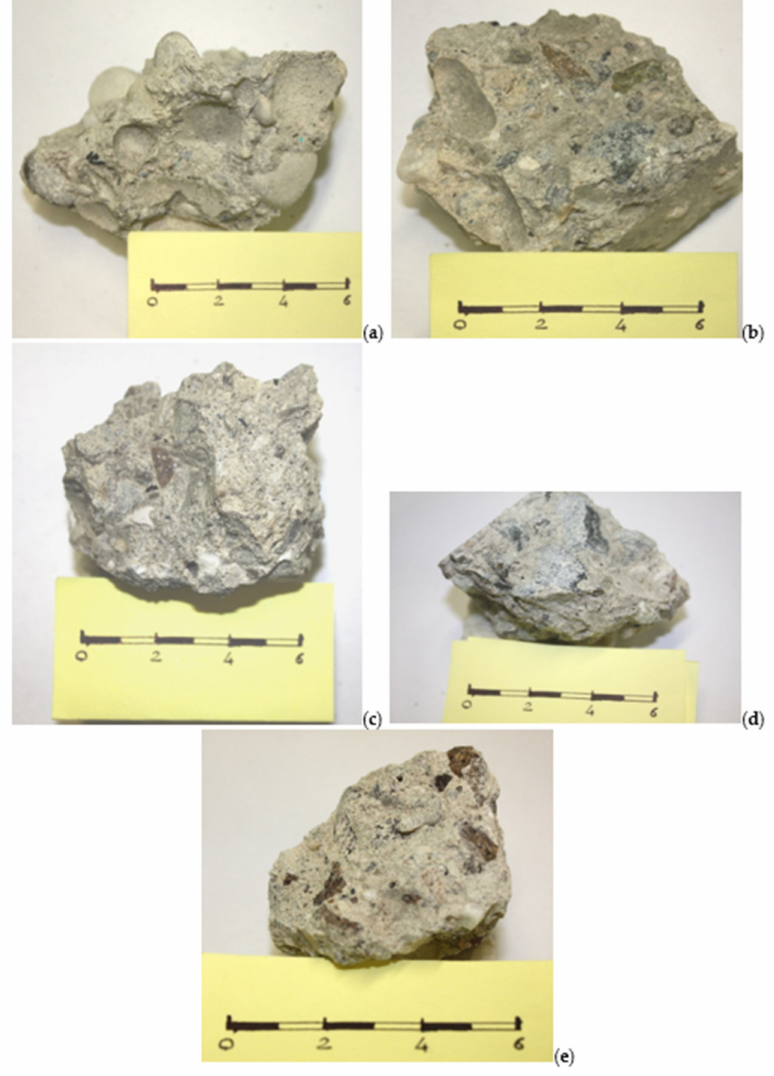
Figure 6. Photo imaging of the concrete mixture analyzed: ( a ) round fragment of calcareous mixture; ( b ) round fragment of metamorphic mixture; ( c ) crushed fragment of calcareous mixture; ( d ) crushed fragment of metamorphic mixture; ( e ) crushed fragment of porphyry